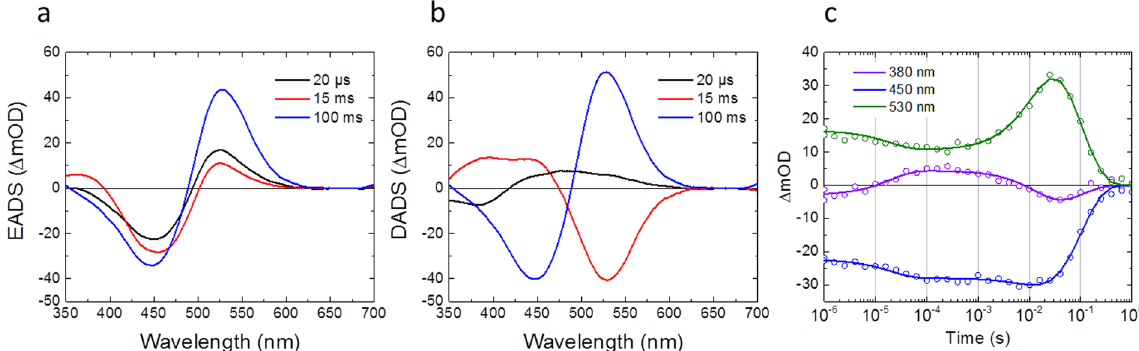
Figure 7. Globally fitted spectra and selected time traces of flash photolysis experiments in C1C2 at pH 8. (a) EADS, (b) DADS and (c) time traces with fitting curves (solid lines) at 380 (purple), 450 (blue) and 530 nm